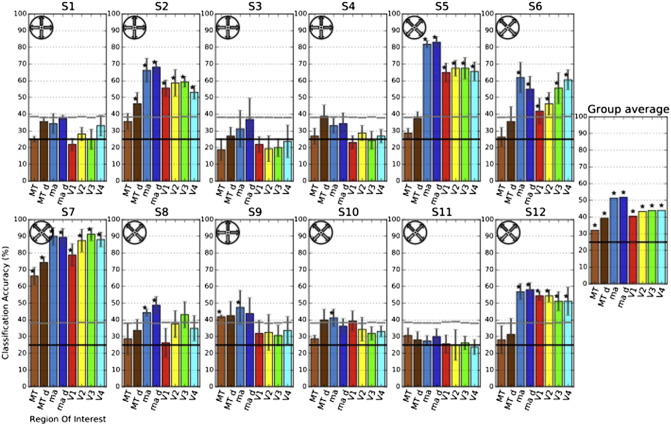
Classification accuracies for imagery of visual motion in four different directions. Average classification accuracies across cross-validations for all subjects (S1–S12) are shown in eight different ROIs. Error bars show one standard deviation of the accuracies' distribution across cross-validations. The black horizontal lines represent the chance level (25%); the gray horizontal lines show the 95th percentile of each 1000-fold permutation test. Asterisks in single subjects indicate significant accuracies (p < 0.05) as assessed by 1000-fold permutation testing. Asterisks in the group average indicate significant accuracies as assessed by Wilcoxon Signed-Rank tests against the average classification accuracy of 1000-fold permutation testing. Orientation wheels at the right show the directions of motion that were imagined by the respective subjects in each row. MT d: 20-fold dilated MT ROI; ma: visual motion-responsive areas ROI; ma d: 10-fold dilated visual motion-responsive areas ROI.